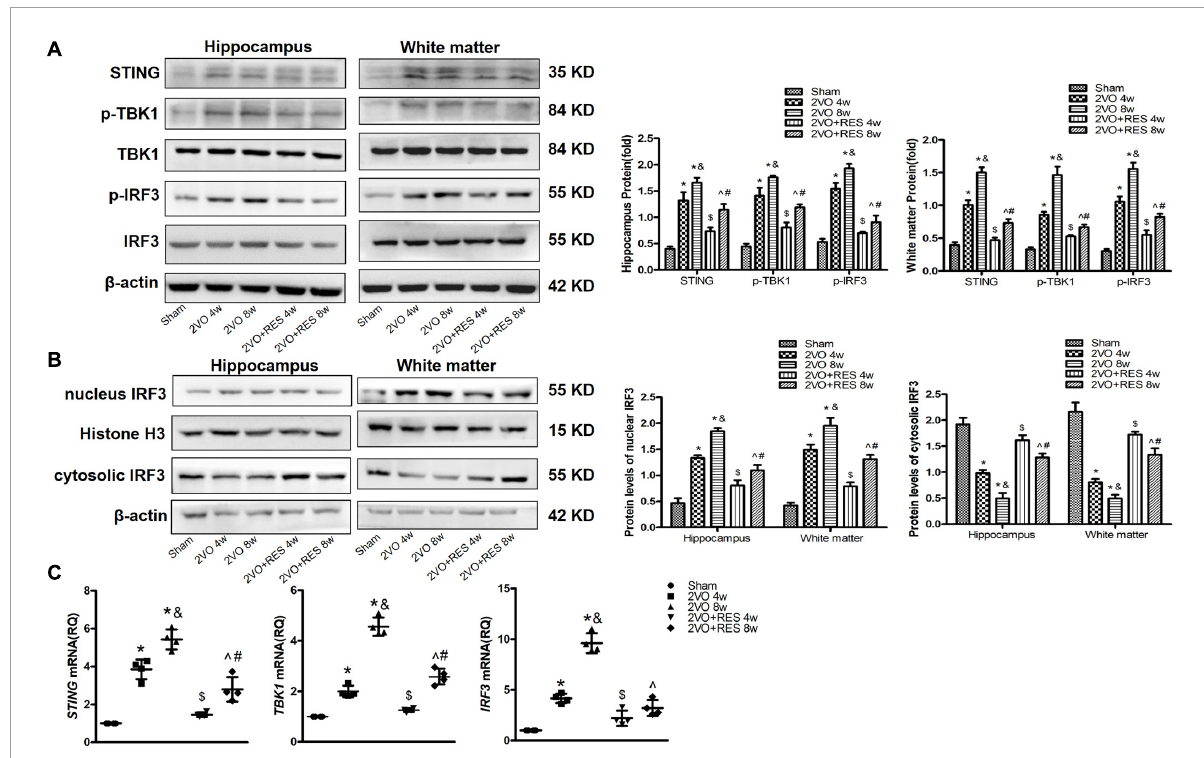
FIGURE6 Increased expression of stimulators of type 1 interferon gene (STING), p-TANK-binding kinase 1 (p-TBK1), and p-interferon regulatory factor 3 (p-IRF3) in bilateral common carotid artery occlusion (2VO) Rats. The expression of STING, p-TBK1, and p-IRF3 was decreased in 2VO rats treated with resveratrol (RES). 2VO promotes the nuclear translocation of IRF3. RES treatment counteracted the nuclear translocation of IRF3. (A) Western blot and quantitative analysis of STING, TBK1, IRF3, p-TBK1, and p-IRF3 at weeks 4 and 8 in hippocampus and white matter extract after 2VO. β -actin was used as an internal control ( n = 3 per group). (B) Western blot analysis of nucleus and cytosolic IRF3 in white matter and hippocampus in different groups after 2VO. β -actin was used as an internal control ( n = 3 per group). (C) mRNA levels of STING, TBK1, and IRF3 in white matter were detected by qRT-PCR. GAPDH was used as an internal control ( n = 4 per group). * p < 0.05 vs. Sham; & p < 0.05, 2VO 8w group vs. 2VO 4w group; # p < 0.05, 2VO + RES 8w group vs. 2VO + RES 4w group; $ p < 0.05, 2VO + RES 4w group vs. 2VO 4w group; ˆ p < 0.05, 2VO + RES 8w group vs. 2VO 8w group. Data are presented as mean ±